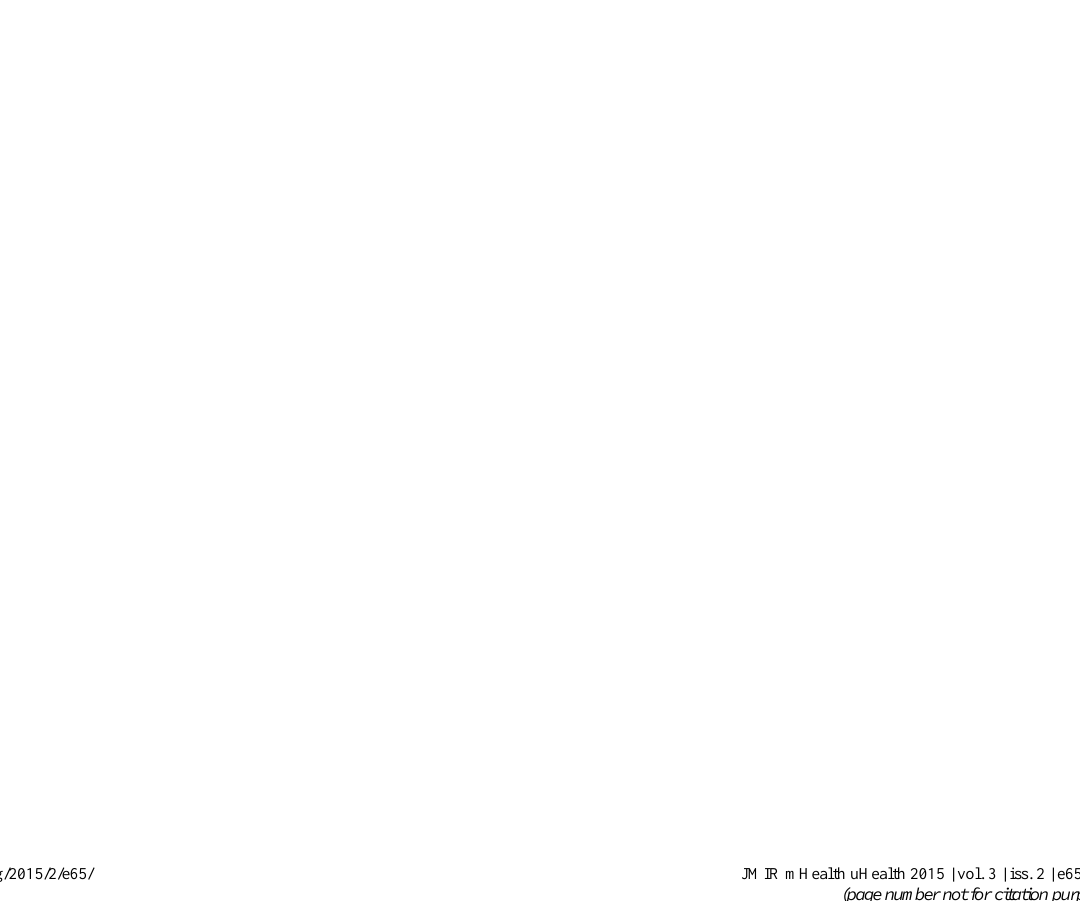
Less likely to take up offer of quicker treatment elsewhere if the alternative hospital has a worse reputation or the appointment involves increased travel time, results in patient paying for transport or requires nonlocal follow-up